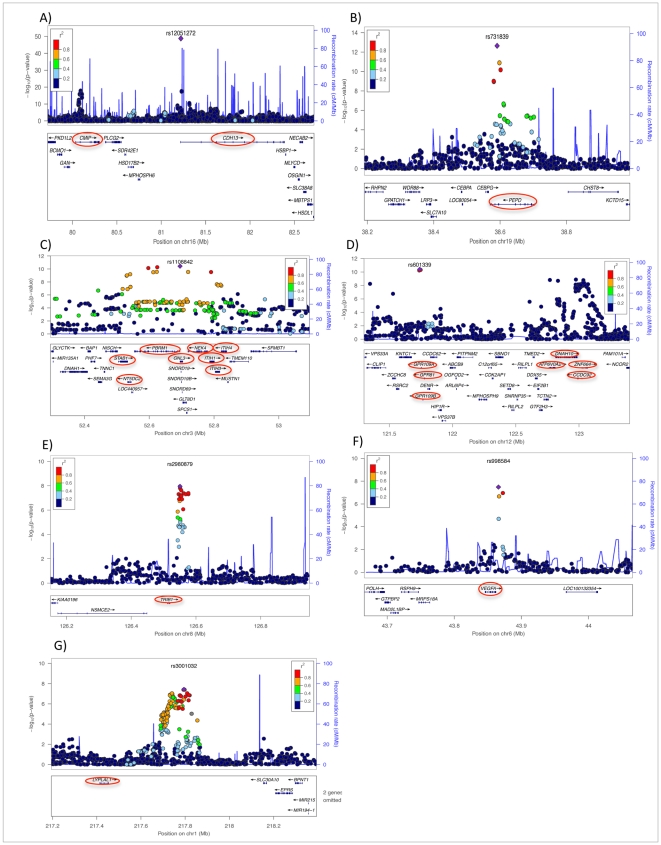
Regional plots of eight newly discovered genome-wide significant chromosomal regions associated with adiponectin concentrations in European populations.A) chromosome 16q23.2, B) chromosome 19 q13.11 C) Chromosome 3p21.1, D) two loci on chromosome 12q24.31, E) chromosome 8q24.13, F) chromosome 6p21.1, and G) chromosome 1q41. In each panel, purple diamonds indicate the top SNPs, which have the strongest evidence of association. Each circle shows a SNP with a color scale relating the r2 value for that SNP and the top SNP from HapMap CEU. Blue lines indicate estimated recombination rates from HapMap. The bottom panels illustrate the relative position of genes near each locus. Candidate genes are indicated by red ovals.